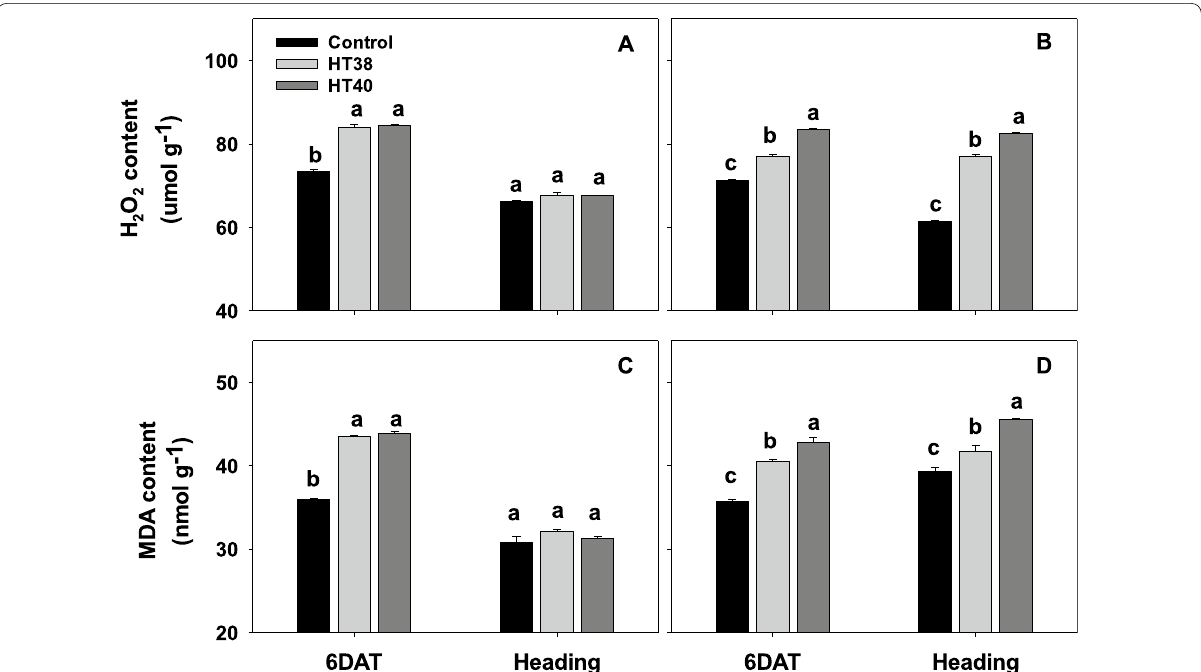
Fig. 6 Hydrogen peroxide (H 2 O 2 ) and malonaldehyde (MDA) in pistils of N22 ( A and C ) and IR64 ( B and D ) at six days after treatment (6DAT) under control and heat stress (38 °C ‑HT38; 40 °C—HT40) at gametogenesis and recovery i.e., at heading. Values shown are mean Bars with common letter are not significantly different between temperature treatments in a genotype at P